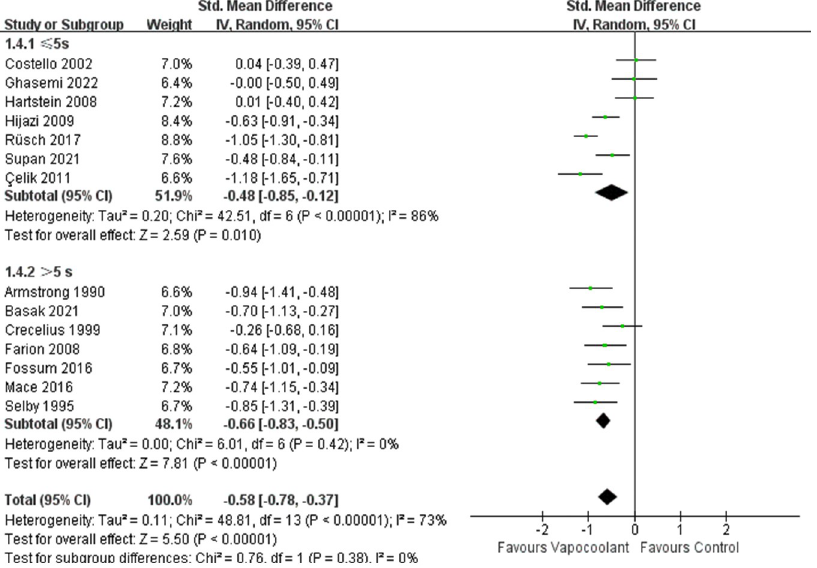
Fig 7. Subgroup analysis of pain scores during intravenous cannulation: Vapocoolants spray time � 5s vs > 5s.